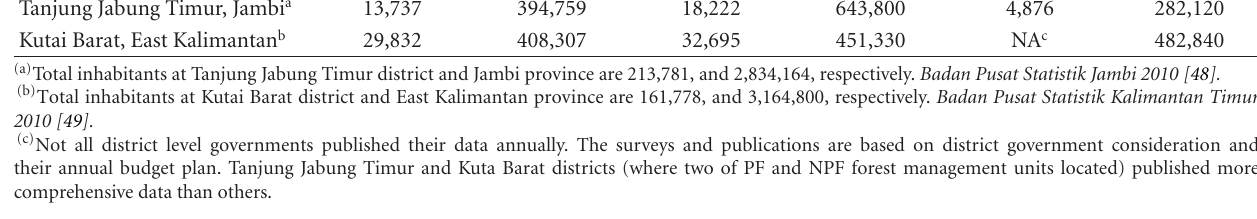
Table 2: Total electricity and gasoline consumption at district and provincial levels in Jambi and East Kalimantan (2009). Total electricity consumption by Name of district/province households (MWh)